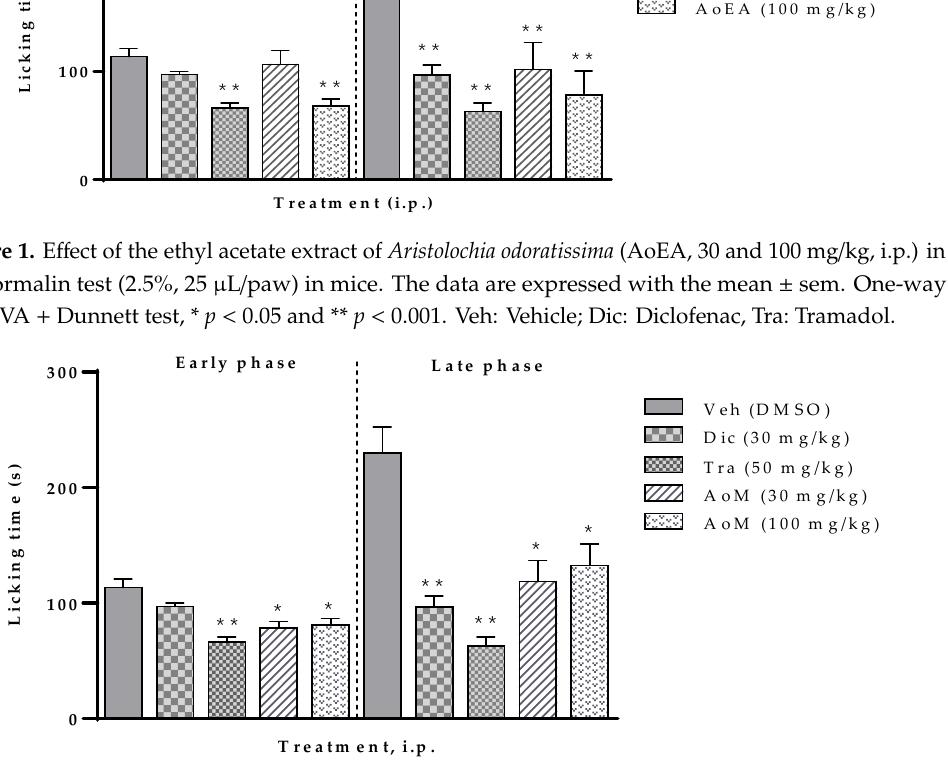
Figure 1. Effect of the ethyl acetate extract of Aristolochia odoratissima (AoEA, 30 and 100 mg/kg, i.p.) in the formalin test (2.5%, 25 µL/paw) in mice. The data are expressed with the mean ± sem. One-way ANOVA + Dunnett test, * p < 0.05 and ** p < 0.001. Veh: Vehicle; Dic: Diclofenac, Tra: Tramadol.